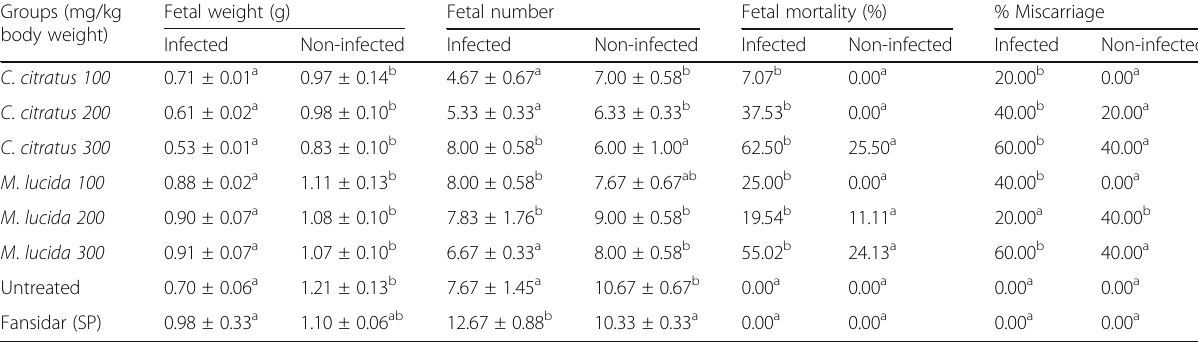
Table 4 Effect of plant extracts on fetal weight, number and mortality of infected and non-infected pregnant mice (before littering) Groups (mg/kg body